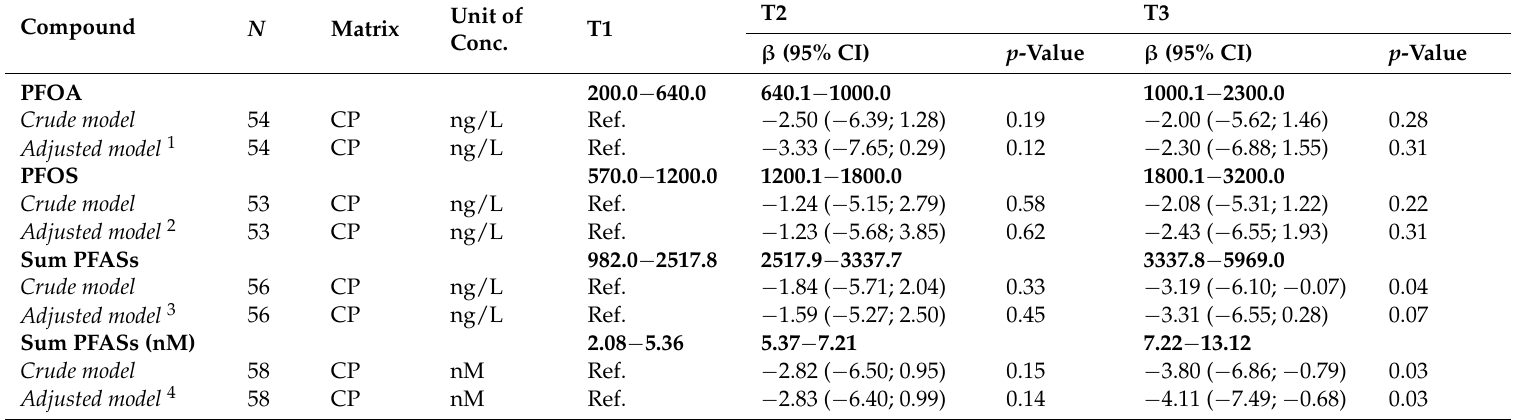
Table A2. Regression coefficients for exposure to perfluoroalkyl substances and scores on the Externalizing Behavior Scale of the CBCL, for the whole population.